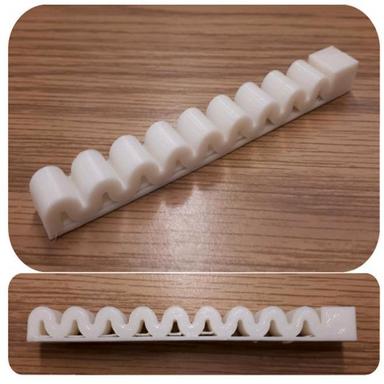
3D printed bellow pneumatic actuator.